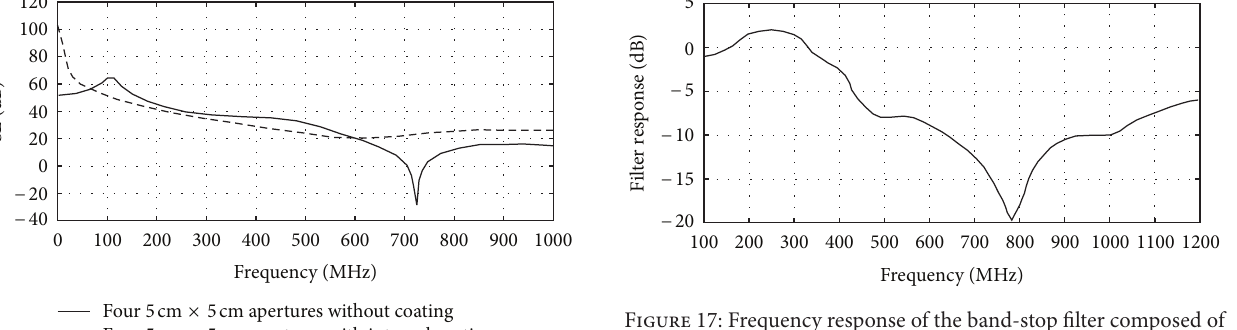
F 15: Shielding effectiveness versus frequency of a 30 box-shapedenclosurewithfour5 30cm in two rows and two columns, illuminated by a plane wave at normal 3 incidence in the presence and absence of a lossy internal coating of 1.5cm thickness.